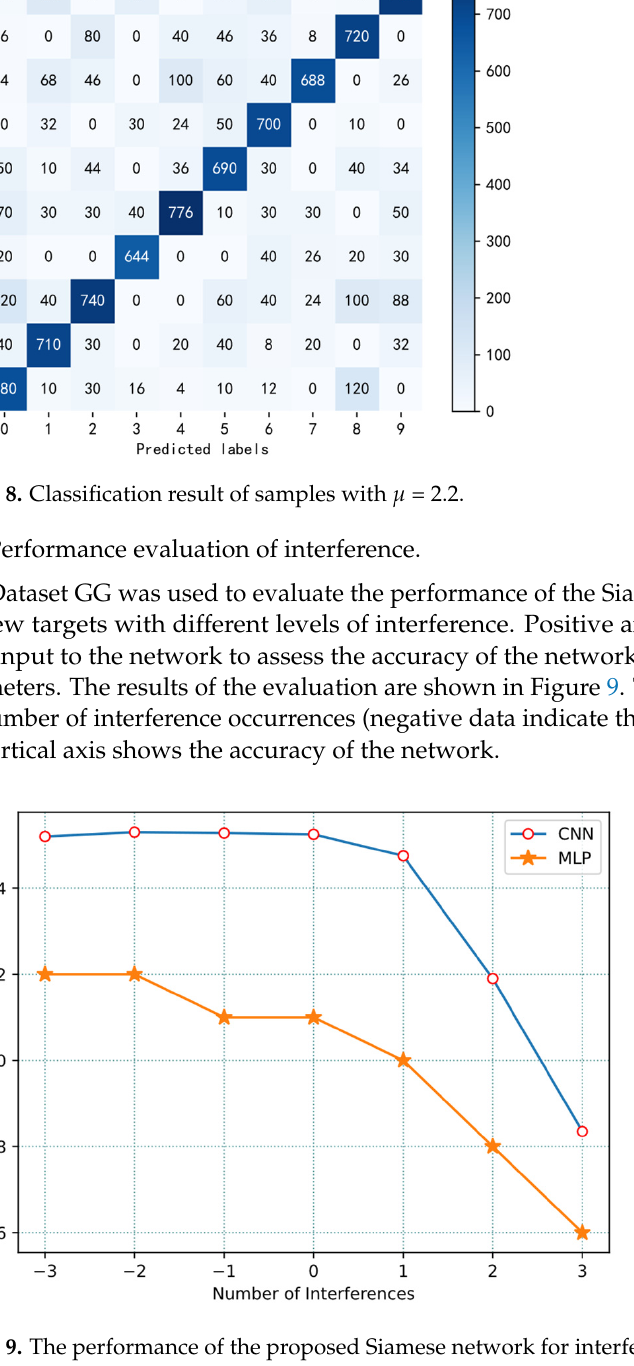
Figure 9. The performance of the proposed Siamese network for